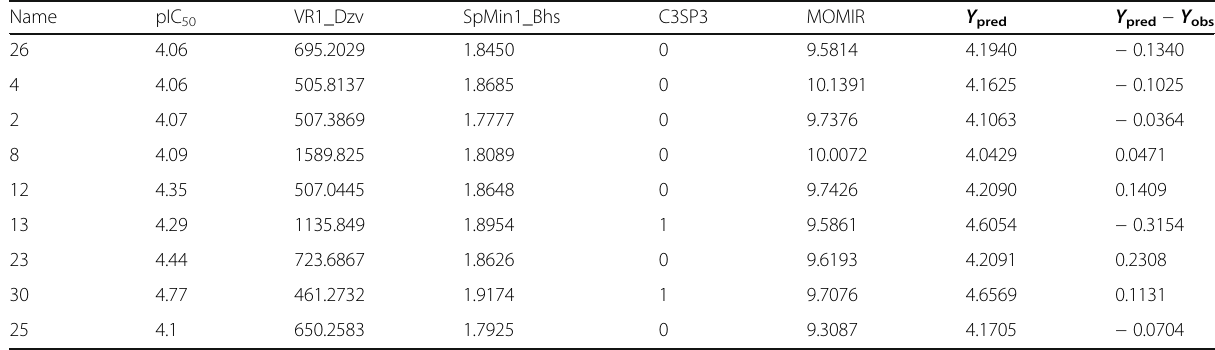
Table 3 External validation of model 4